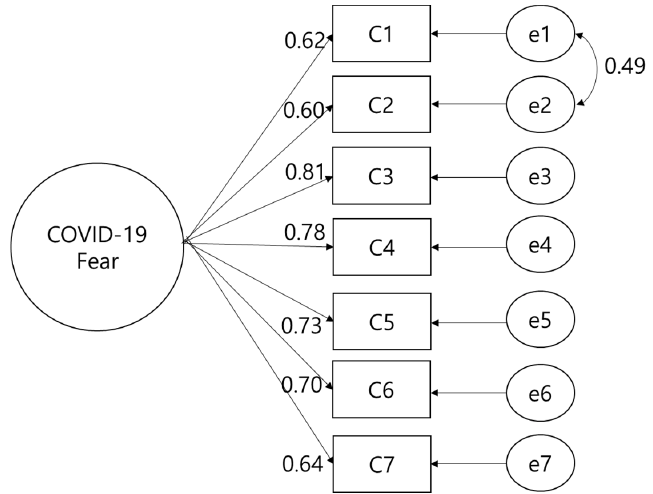
Figure 1. Confirmatory factor analysis.